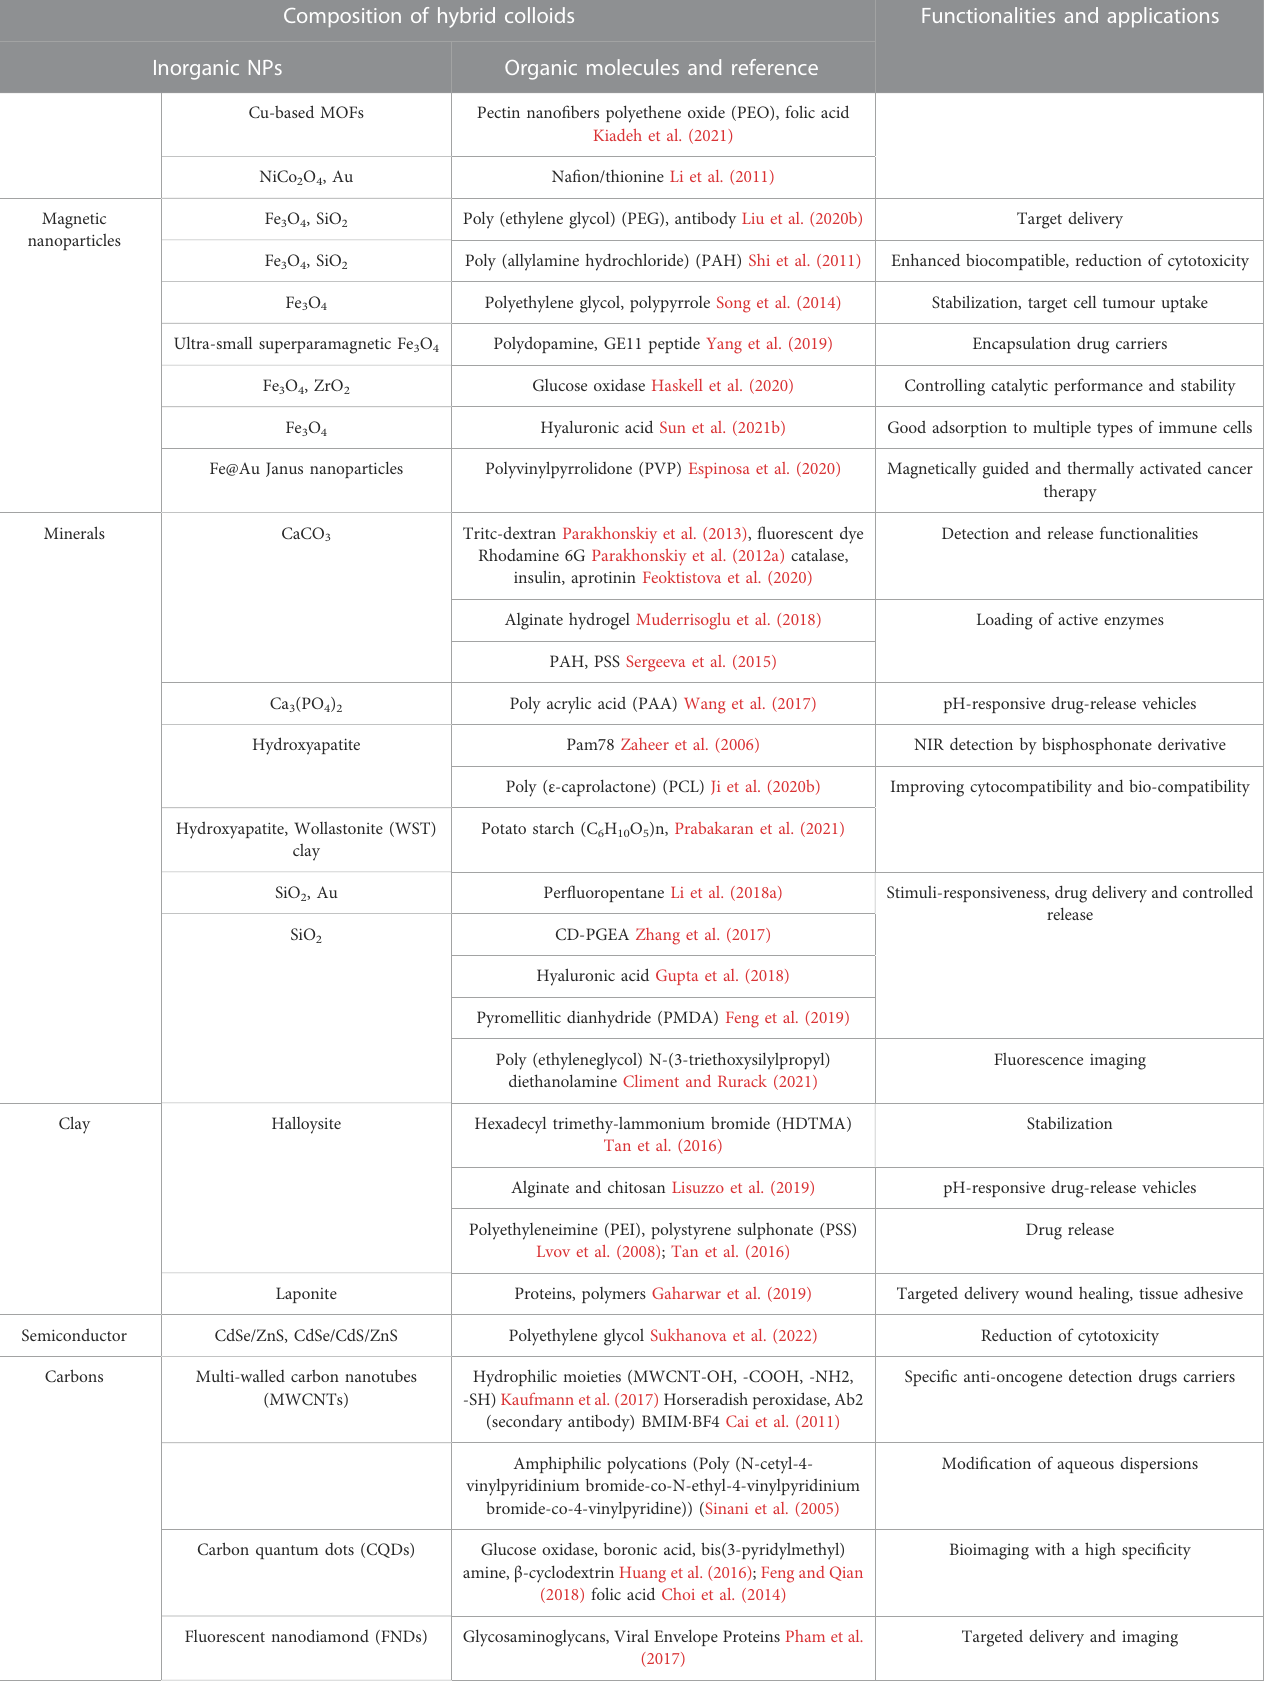
TABLE 1 ( Continued ) The overview of the studies of hybrid organics-on-inorganics colloidal and their composition,